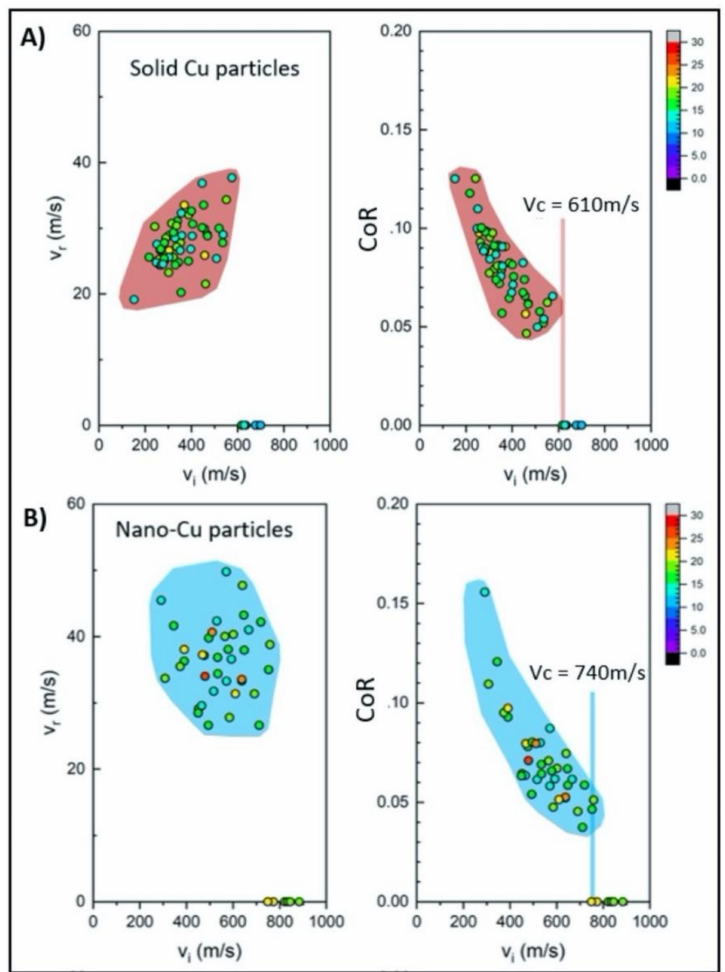
Figure 10. V r and CoR vs. V i for ( A ) GA Cu (labeled as “Solid Cu particles”) and ( B ) spray-dried Cu (labeled as “Nano-Cu particles”)